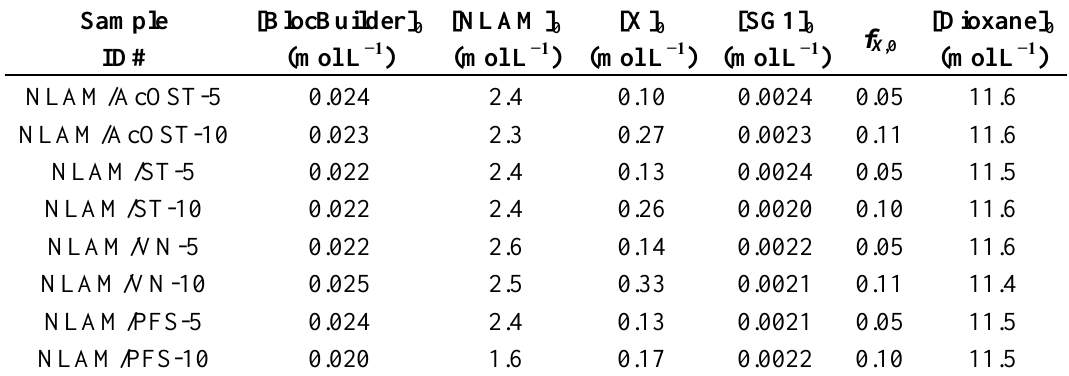
Table 1. Formulations for 5-methacryloyloxy-2,6-norboranecarbolactone (NLAM)/X (X = controlling co-monomer) random copolymerizations initiated by BlocBuilder at 90 °C in 35 wt% 1,4 dioxane